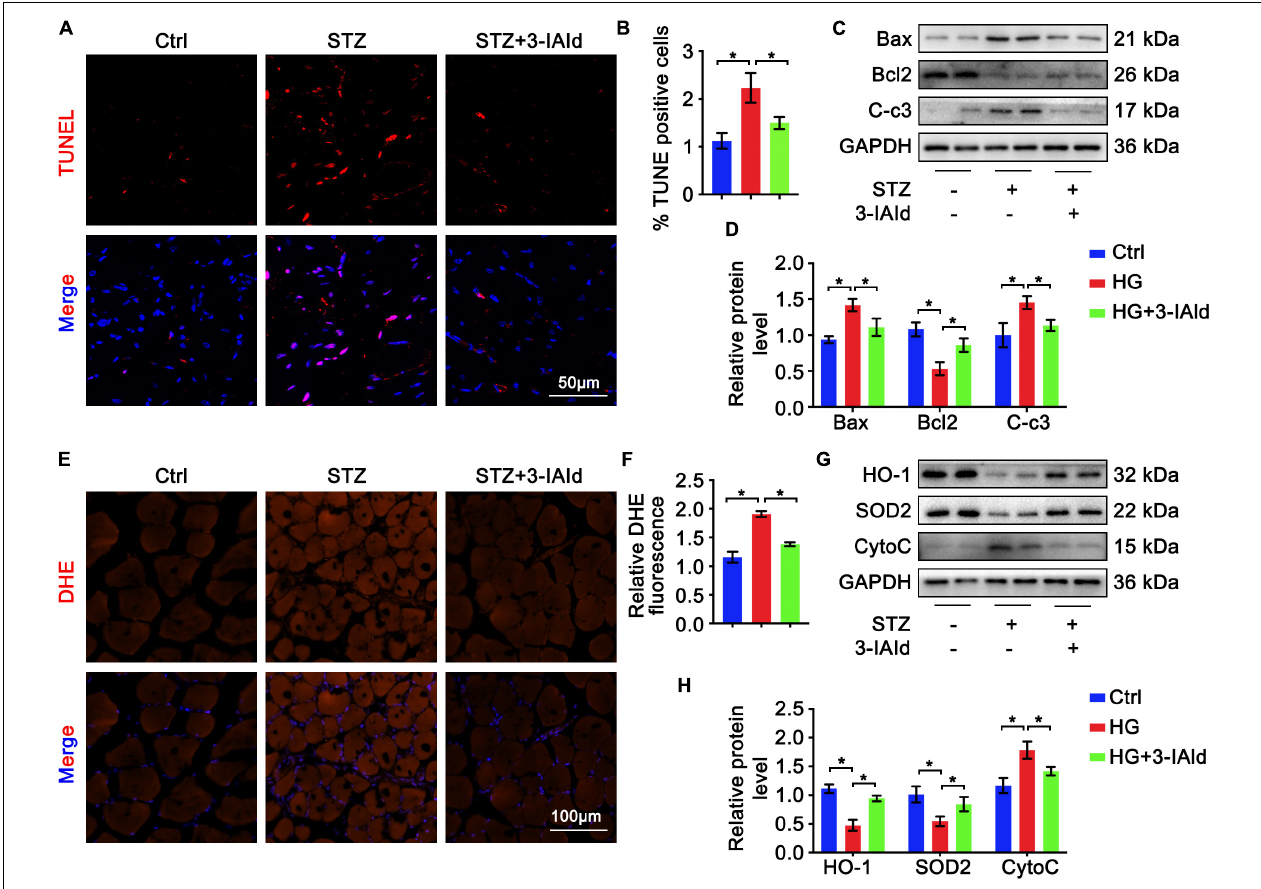
FIGURE 3 | 3-IAld alleviates oxidative stress and apoptosis in diabetic HLI. (A) TUNEL staining of diabetic mice in the control, STZ and STZ + 3-IAId groups at 7 days after ligation; scale bar: 50 µ m. (B) Quantification of TUNEL staining; n = 6 for each group. (C) Western blot analysis of apoptosis-related molecules in the diabetic mice in the control, STZ and STZ + 3-IAId groups at 7 days after ligation. (D) Quantification of relative protein levels; n = 6 for each group. (E) DHE staining of diabetic mice in the control, STZ and STZ + 3-IAId groups at 7 days after ligation; scale bar: 100 µ m. (F) Quantification of DHE staining; n = 6 for each group. (G) Western blot analysis of oxidative stress-related molecules in the diabetic mice in the control, STZ and STZ + 3-IAId groups at 7 days after ligation. (H) Quantification of relative protein levels; n = 6 for each group. Data are presented as the mean ± SEM. * P <